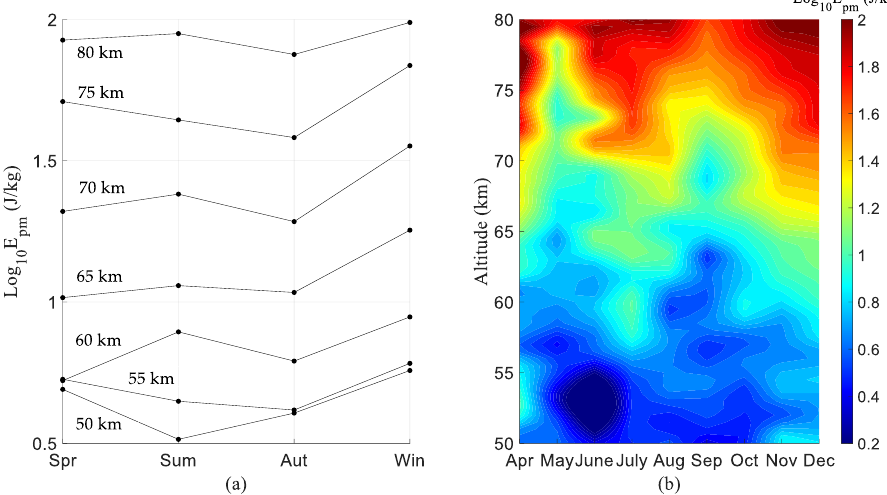
Figure 6. ( a ) Seasonal averaged E pm at several altitude points. ( b ) Contour plot of monthly averaged E pm (April to December).